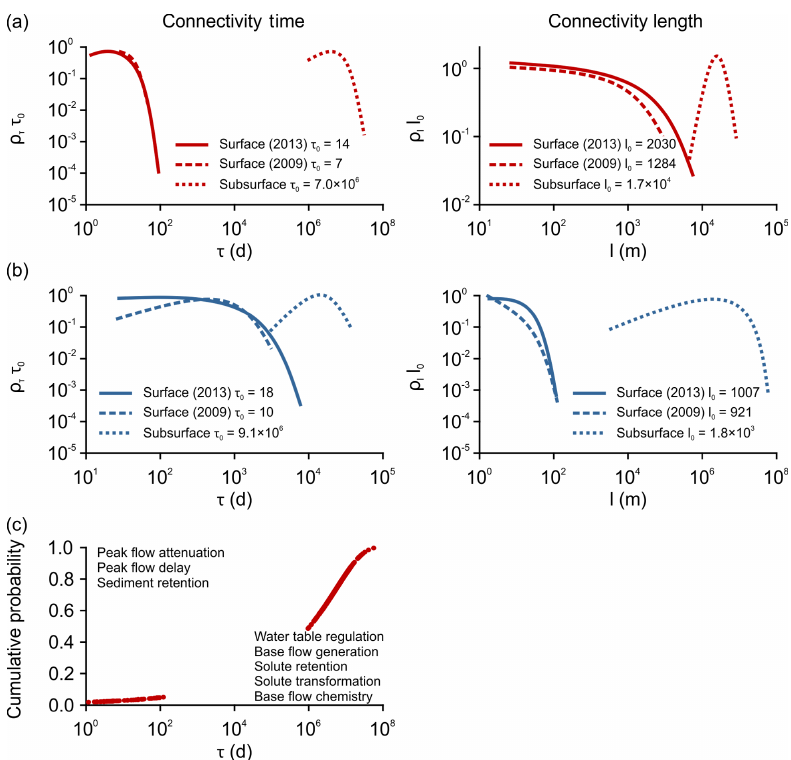
Figure 6. Fitted probability density function of subsurface or surface (both 2009 and 2013) connection transit times ( ρ τ – left panel) and connection lengths ( ρ l – right panel) (a) between wetlands and the North Saskatchewan River and (b) from wetlands located in the moraine and other wetlands throughout the watershed. l 0 [m] and τ 0 [d] refer to the average length and transit time, respectively. The axes labels were explained in Sect. 2.3.3 (Eq. 2). (c) Cumulative probability of transit time distribution of water particles discharged from wetlands into the North Saskatchewan River. The potential ecosystem services of each portion were also